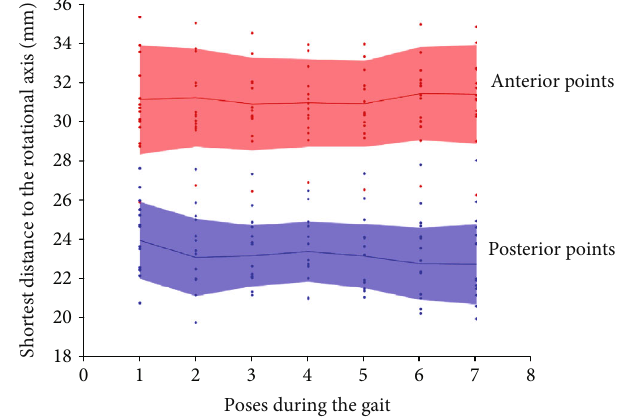
Figure 4: Shortest distance from the anterior or posterior points of the talus to the GATJ at the stance phase of the gait cycle (Pose